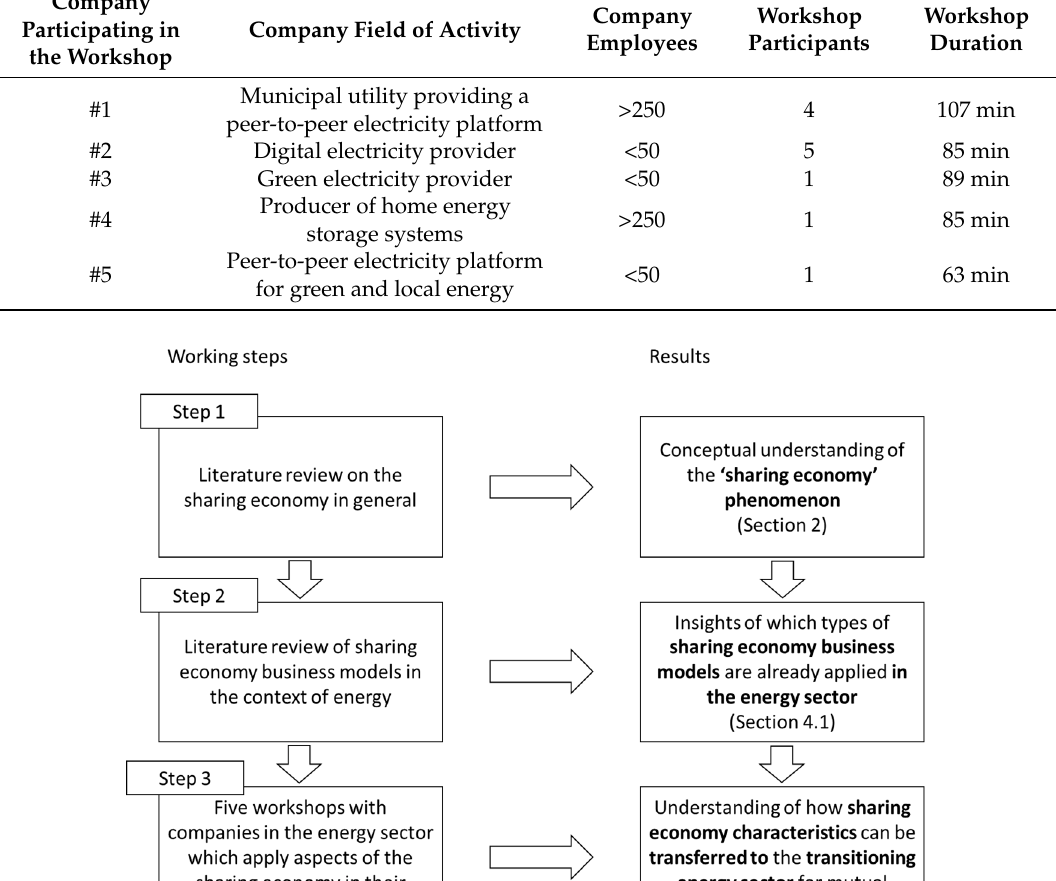
Table 3. Overview of conducted company workshops.